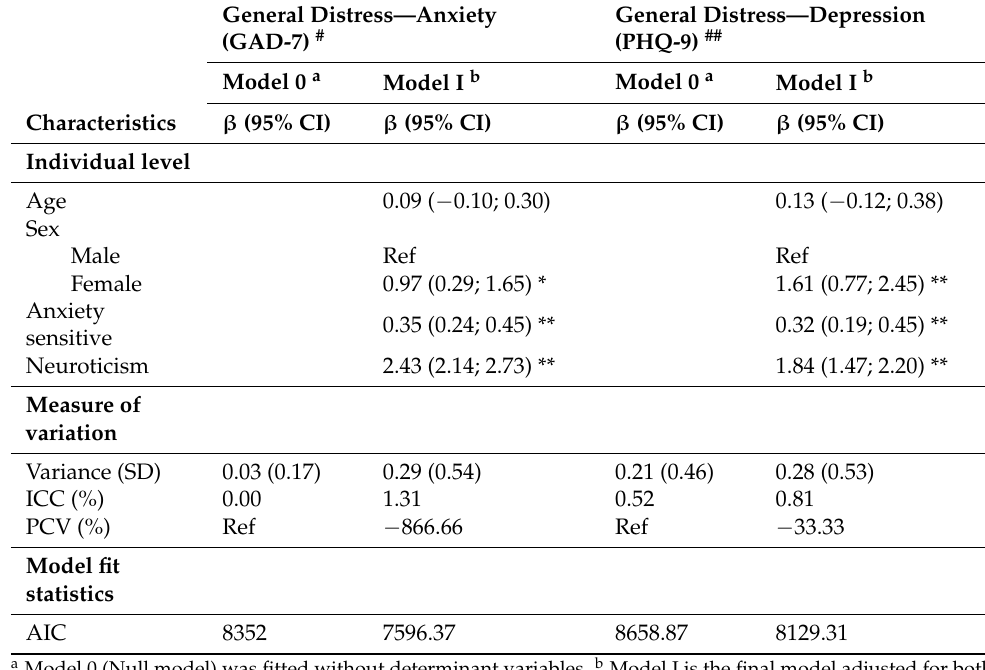
Table 3. Factors associated with General Distress: Anxiety (GAD-7) and Depression (PHQ-9). General